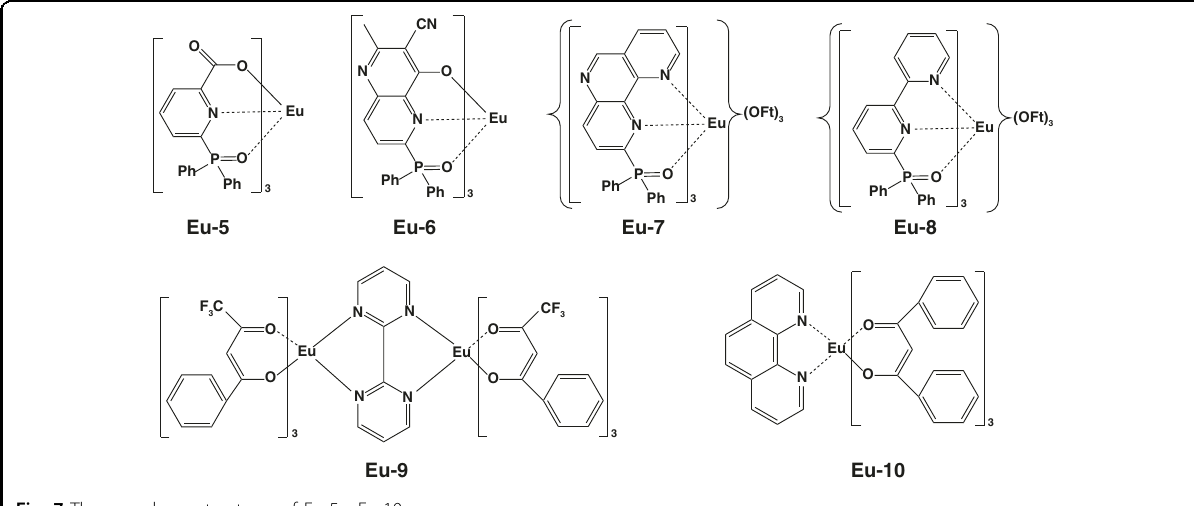
Fig. 7 The complexes structures of Eu-5 - Eu-10